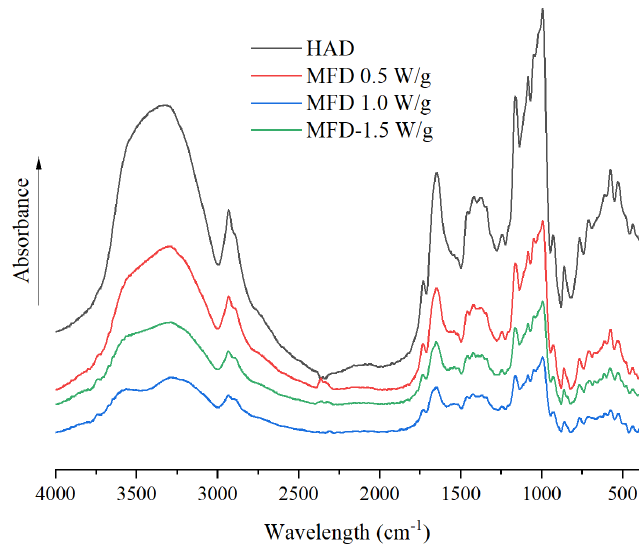
Figure 3. FTIR spectra of yam flours dried by HAD and MFD.